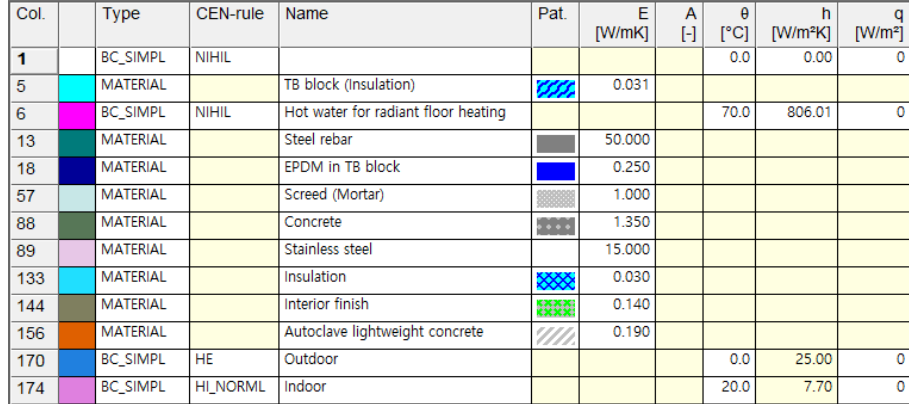
Figure 4. 3D view of the investigated apartment house. TRNSYS simulation models were developed in accordance with the above-men- tioned Physibel simulation models, including the structure layers, external and internal thermal insulation systems, and two types of TB elements. Therefore, the heating energy demand of the apartment was also analyzed with radiant floor heating and air heating system. The simulation of heating energy demand was performed for a heating period of one year, with hourly time step. The heating period was defined based on the input weather data. EnergyPlus weather (EPW) data of Incheon [46] was applied to utilized for the annual simulation. In order to maintain the same boundary conditions with Physibel simulation, the indoor heating temperature was set to 20 °C. The occupancy schedule was set from 6 p.m. to 9 a.m. of the next day. In this study, the peak heating load and seasonal